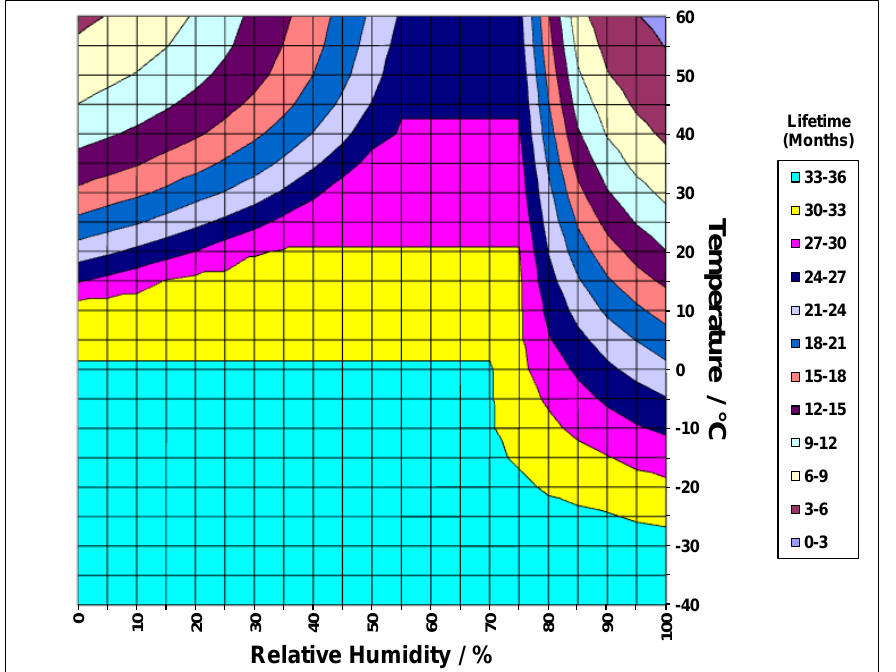
Figure 2. Example of lead-based sensor model outputs. Lifetime predictions for continuous operation at selected temperatures and relative humidities (modified from